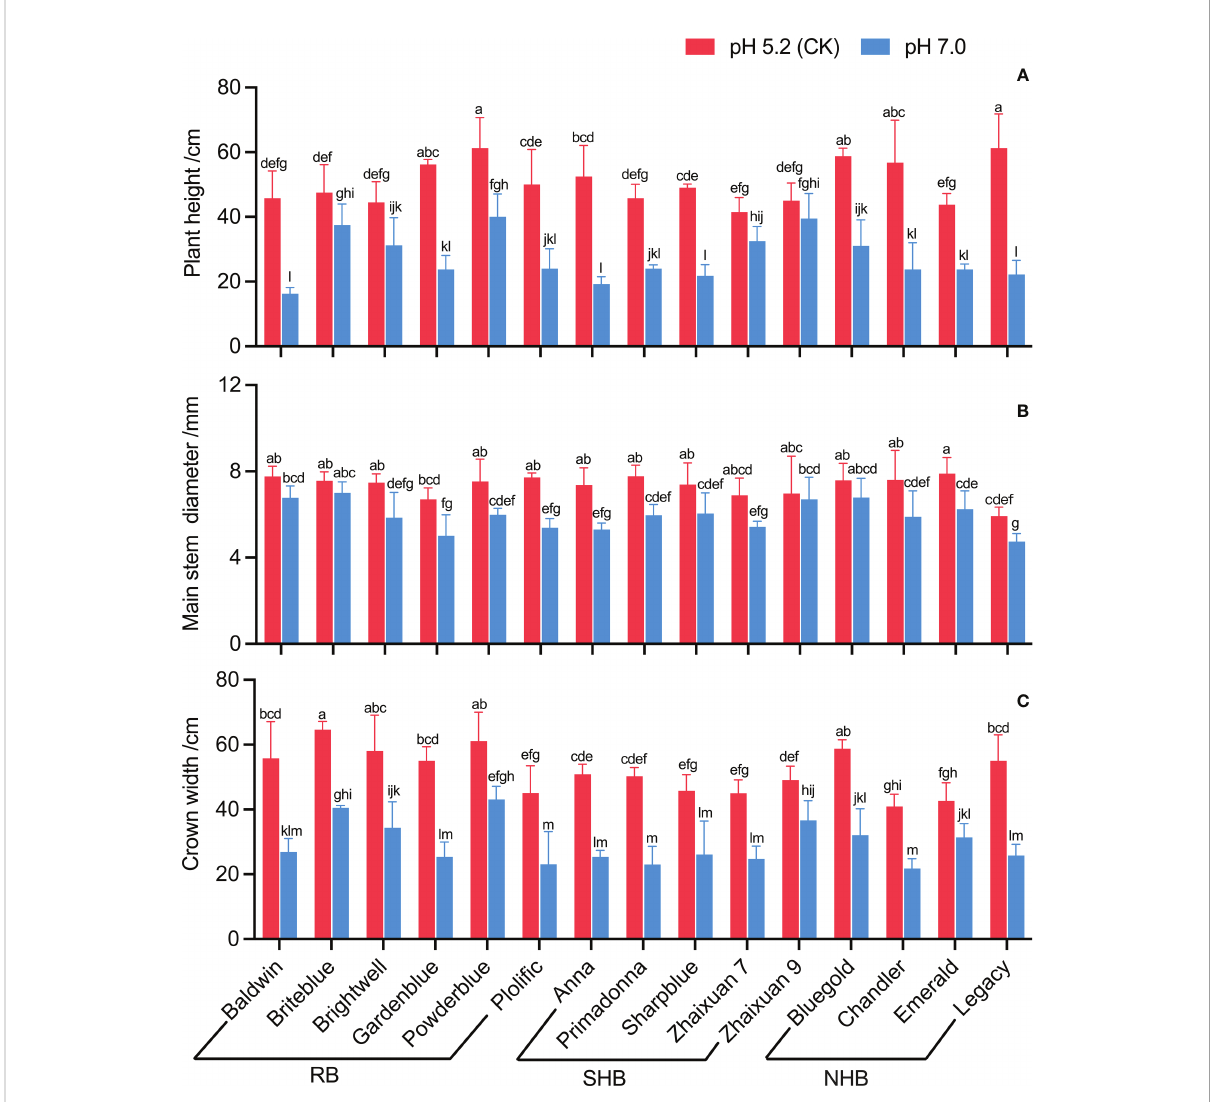
FIGURE 2 Effects of high soil pH stress on the growth characteristics of 15 blueberry seedling cultivars. The plant height (A) , main stem diameter (B) , and crown width (C) . Columns with different letters signi fi cantly (p<0.05) differed based on Duncan ’ s multiple range